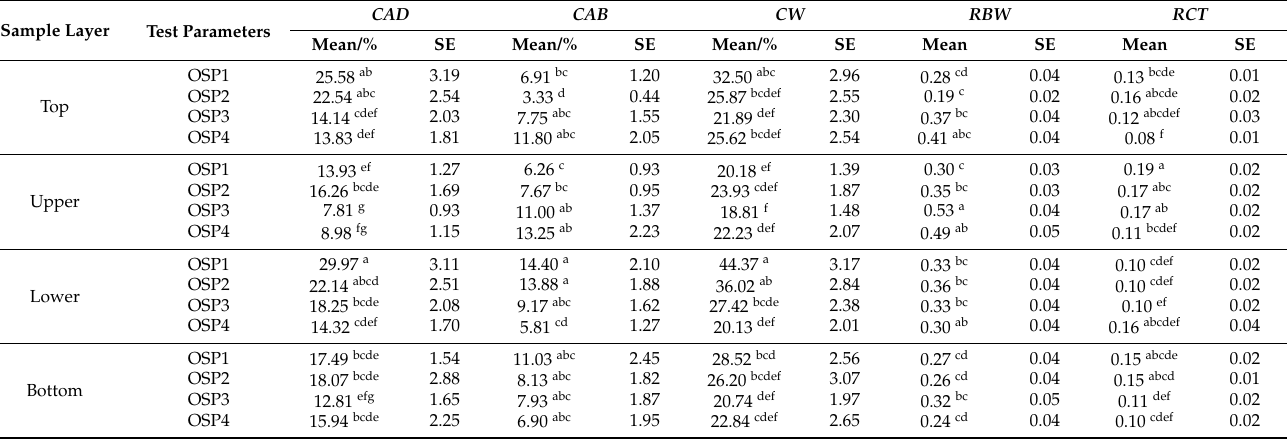
Table 3. Results of spray tests on pear: CAD , CAB , CW , RBW, and RCT of OSP1-OSP4.